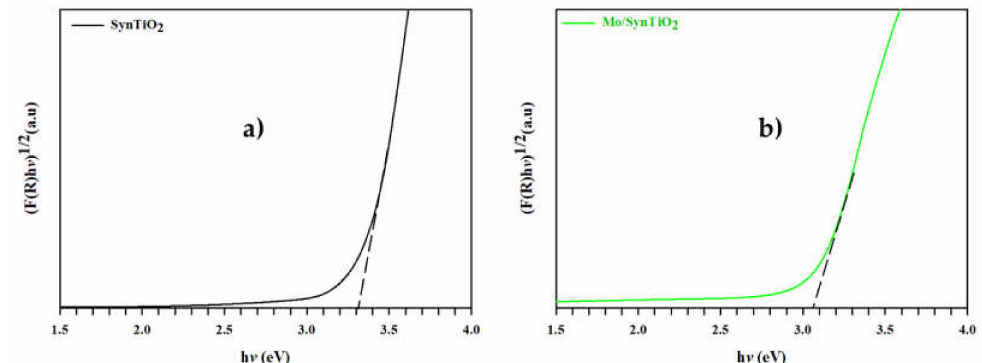
Figure 6. Energy bandgap (Eg) estimates for: ( a ) unmodified SynTiO 2 and ( b ) modified Mo/SynTiO 2 material